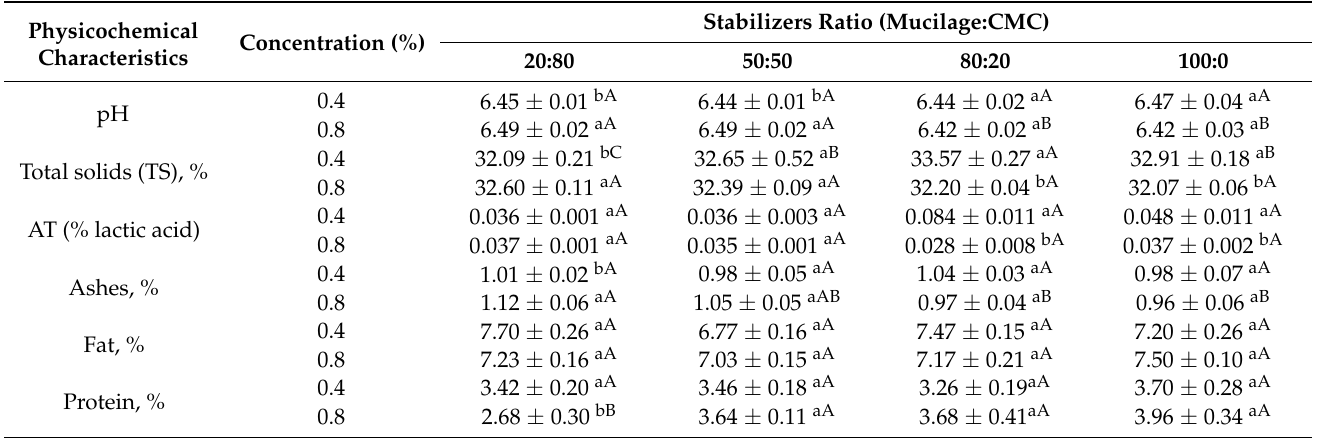
Table 2. Average values of vanilla-flavored soft serve ice cream physic-chemical